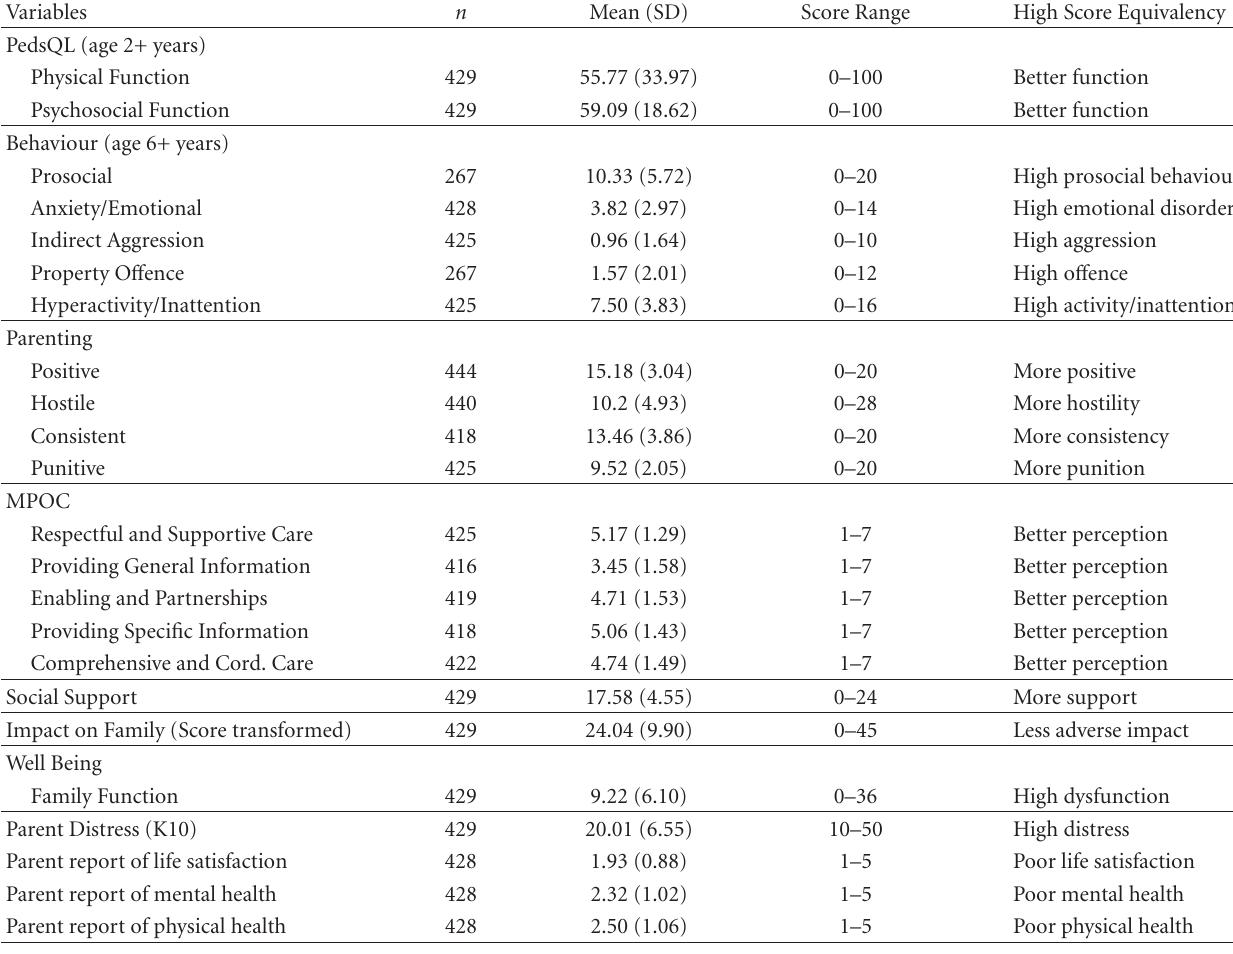
Table 3: Range, high score equivalency and mean sample scores for measured variables.